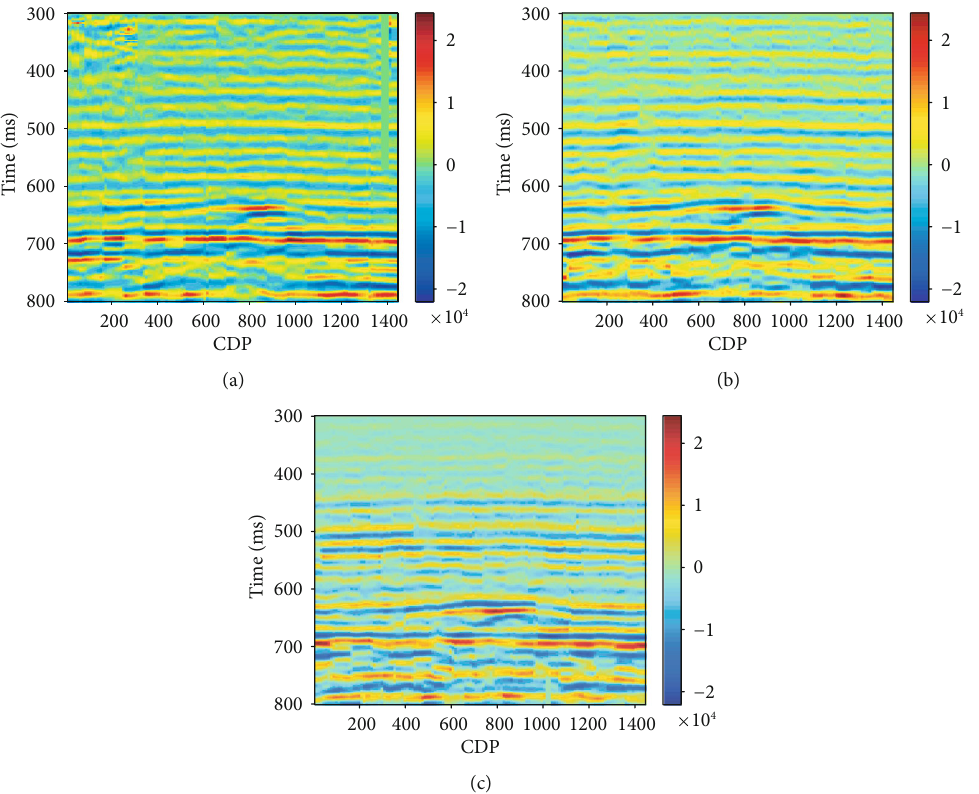
Figure 10: Partially stacked angle gathers of (a) small-angle range, (b) middle-angle range, and (c) large-angle density, and porosity. Based on the interpretation results of Figure 11. To estimate the four AVO parameters proposed in the well log, the empirical parameter of the statistical func- this paper, we combine the rock physics and the well log data. tion can be determined and used for Gassmann ’ s equation The well log can provide the P-wave velocity, S-wave velocity,